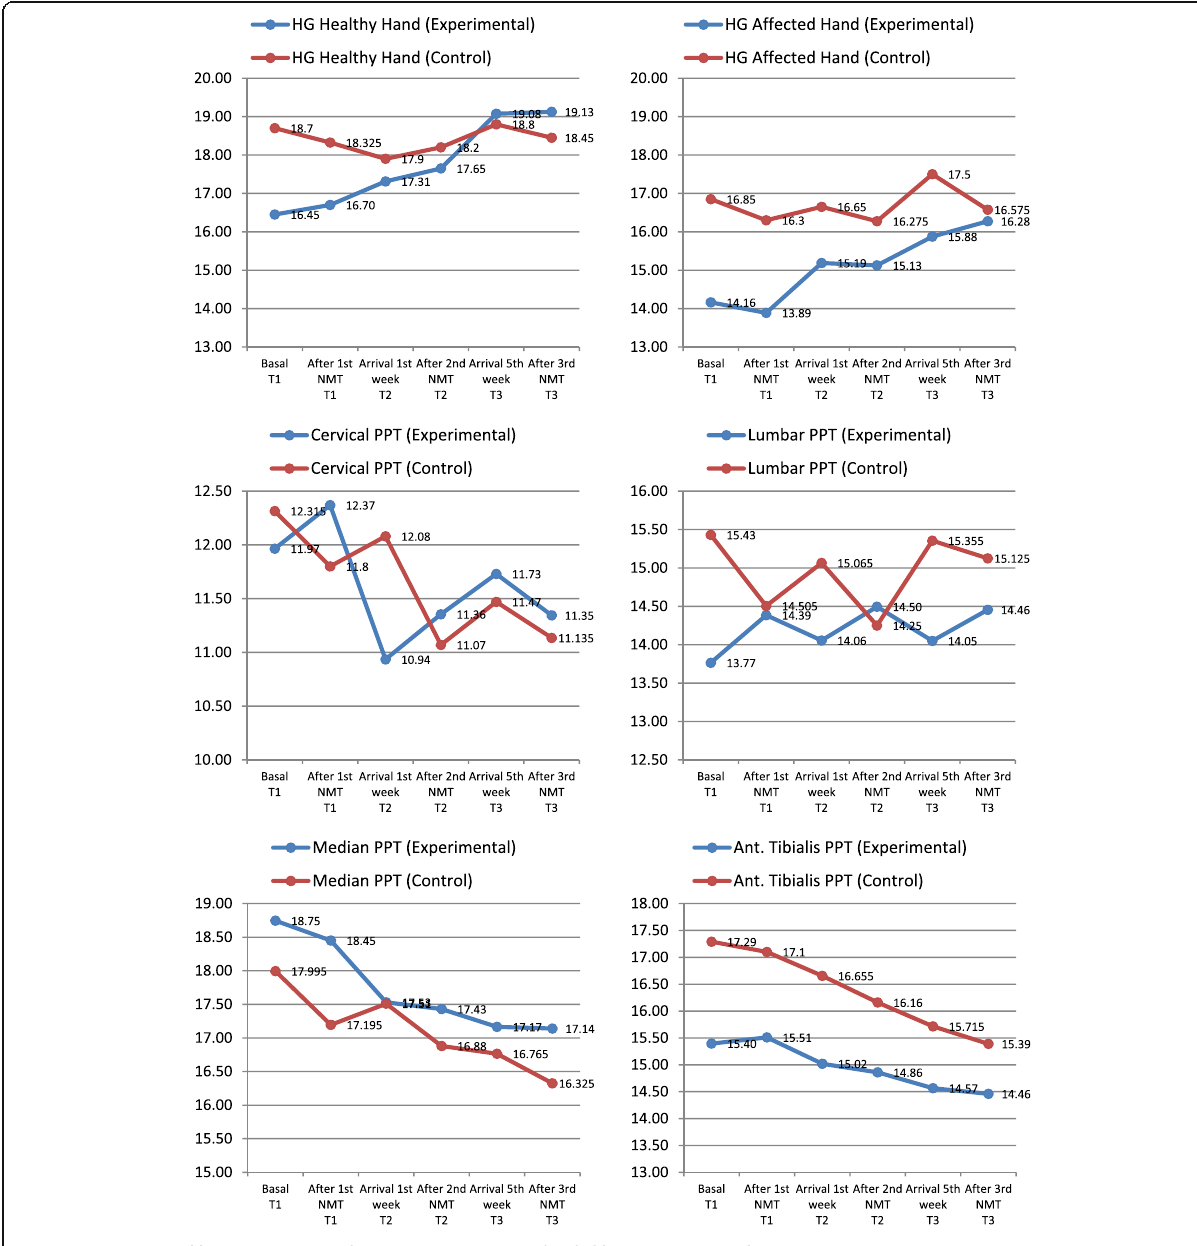
Fig. 3 Means of objective measures from both groups at different times of the